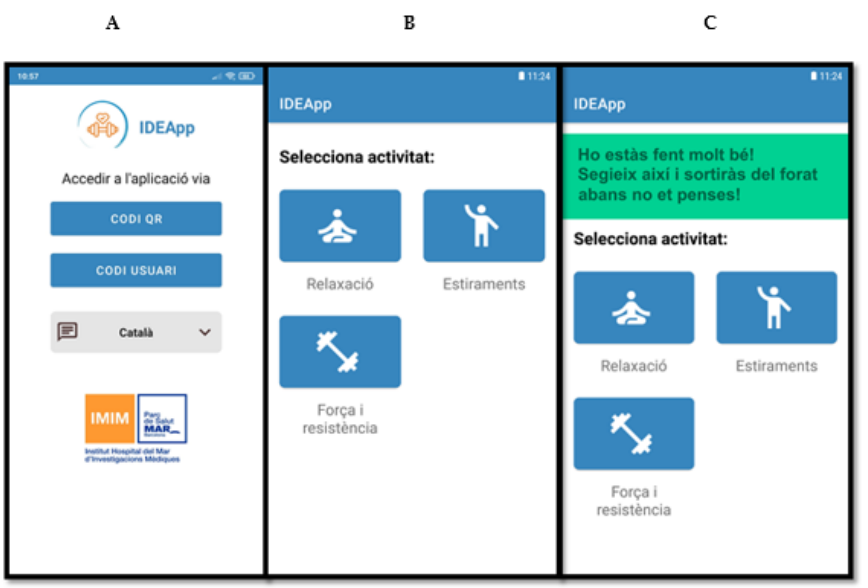
Figure 2. Screenshots of IDEApp running on a smartphone (messages in Catalan). ( A )—login and register screen; ( B )—home Screen without notification; ( C )—home screen with motivational notifi- cation